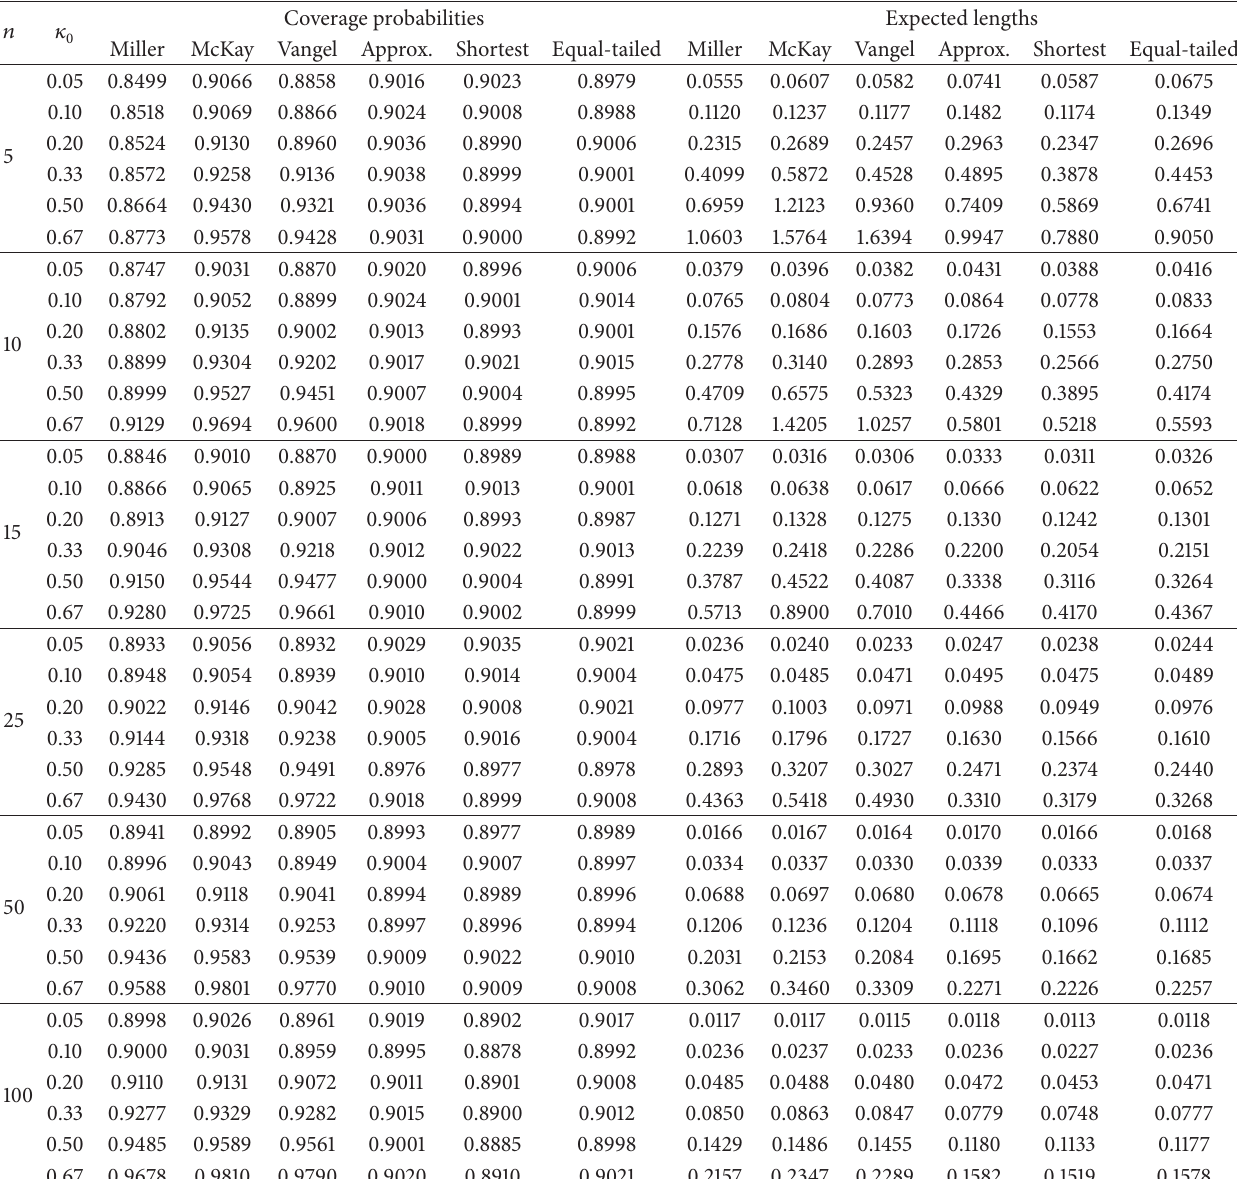
Table 2: The estimated coverage probabilities and expected lengths of 90% confidence intervals for the coefficient of variation in a normal distribution with a known population